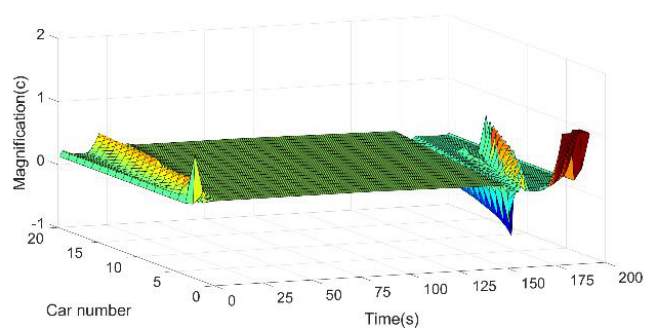
Figure 10. Vehicle current in driving situation 4.